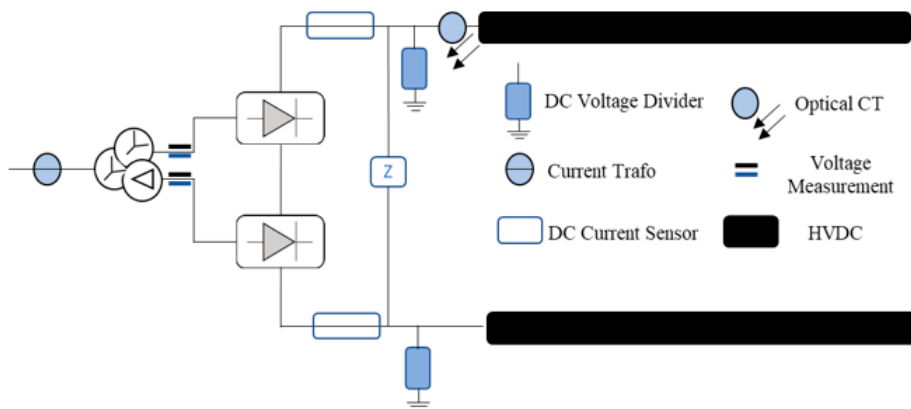
Figure 11. Measurement device placement in a HVDC converter station.